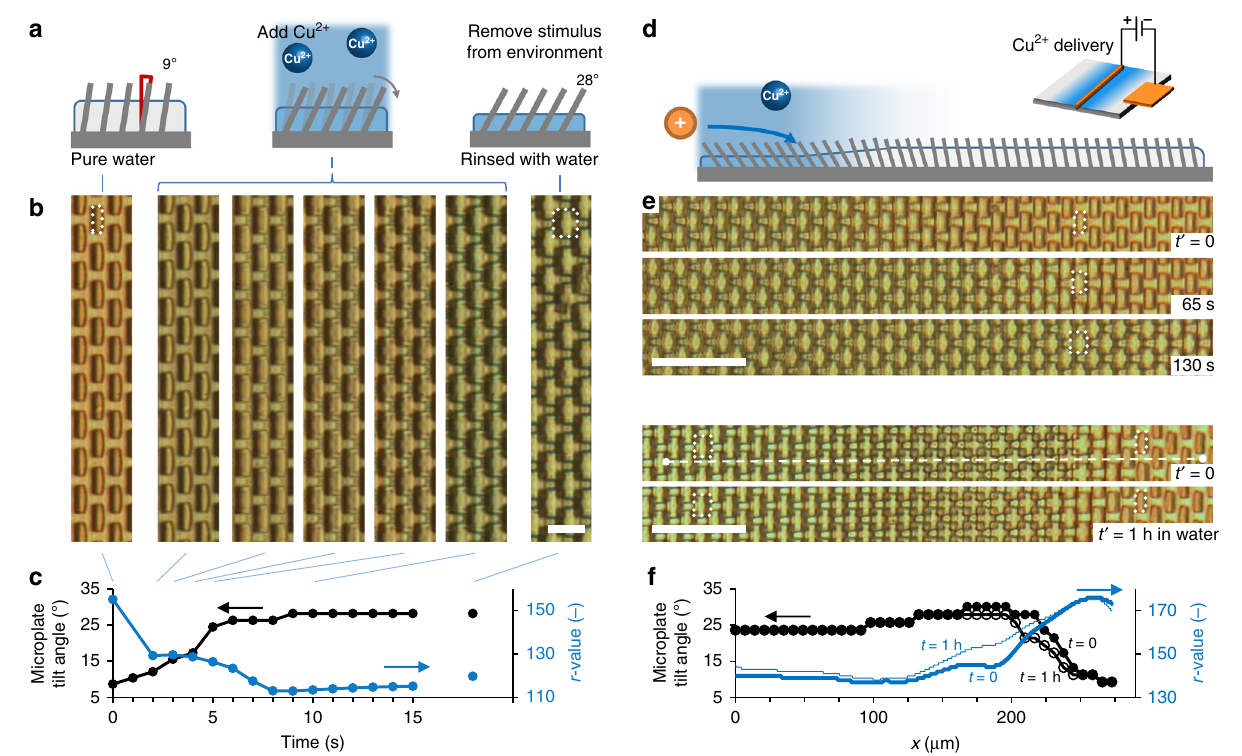
Fig. 2 Delivery and storage of a Cu 2 + stimulus. a Scheme of the Cu 2 + complexation, hydrogel contraction, and microplate tilting upon exposure to Cu 2 + , and the maintenance of this response upon the formation of kinetically stable complexes after the stimulus is removed from the external environment. b Optical microscopy images showing that the addition of copper(II) sulfate (see Methods) leads to progressive microplate tilting, concurrent with a progressive colorless-to-blue transition of the hydrogel, indicative of COO − -Cu 2 + -COO − complexation. The white dotted outlines indicate the change of the cross-sectional view of a single plate from rectangular (in the upright state) to nearly square (in the tilted state). Scale bar: 15 μ m. c Data corresponding to microscopy images of the microplate tilt angle (black, reported as the angle between microplate and normal to the substrate, see Methods), and Cu 2 + complexation (blue, reported as r value, i.e. red-channel value of the optical micrographs). The tilt angles and blue color are maintained after rinsing the substrate with water (right image in b). d Scheme showing Cu 2 + ions electrochemically delivered from a positively charged copper electrode wire. e